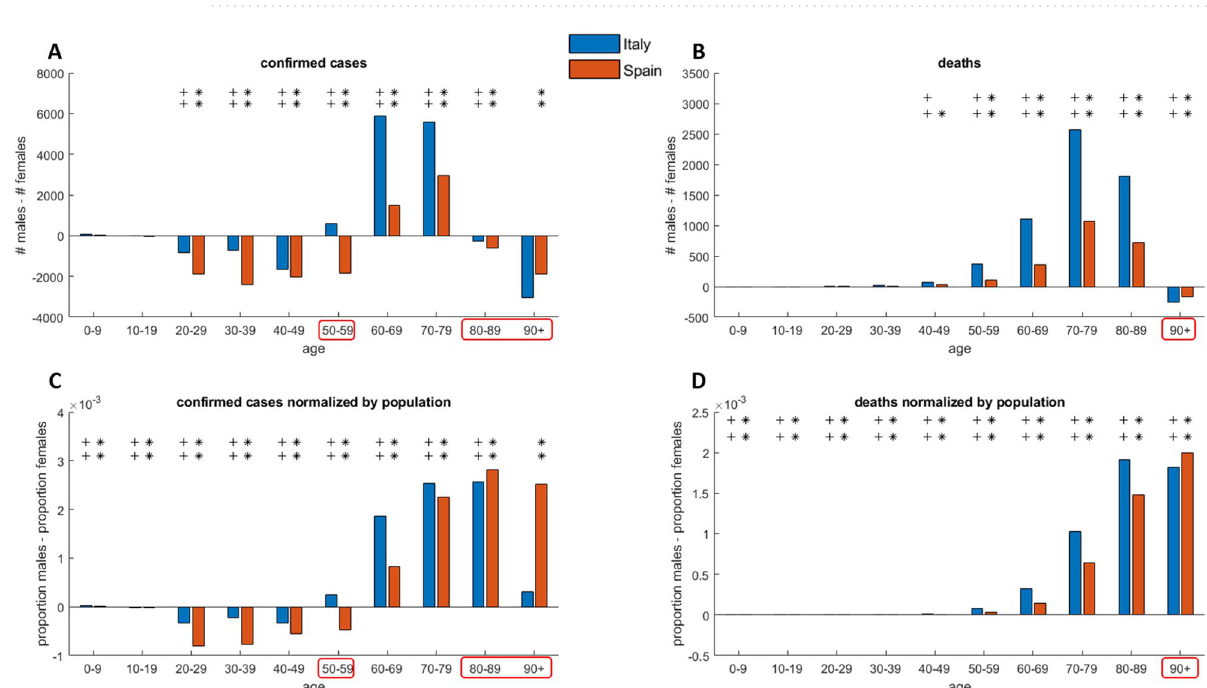
Figure 3. Data comparison of Spain and Italy COVID-19 outbreak for open access variables which are common to both national data sources. (A) Confirmed cases, (B) deaths, (C) confirmed cases normalized by national population, (D) deaths normalized by national population. The presence of at least one symbol (star for Spain and plus for Italy: 1 symbol indicates p-values below 0.05, 2 symbols p-values below 0.001) on top of a specific age strata indicates that the sex inequality is statistically significant. The red boxes on the age ranges on x-axis denote data that are not in agreement: either between the nations or between the variables before and after normalization adjustment. For all panels, the line on zero indicates the threshold over which, for the respective variable, the impact of COVID-19 on males is larger than on